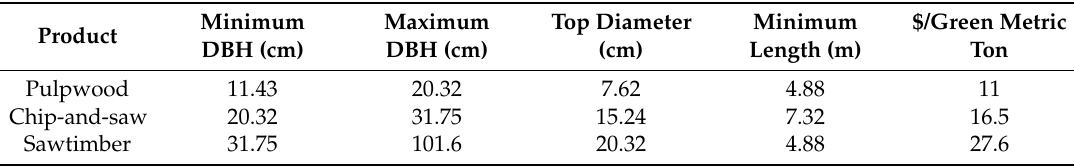
Table 5. Product specifications used in individual installation, management, and planting density combination product value